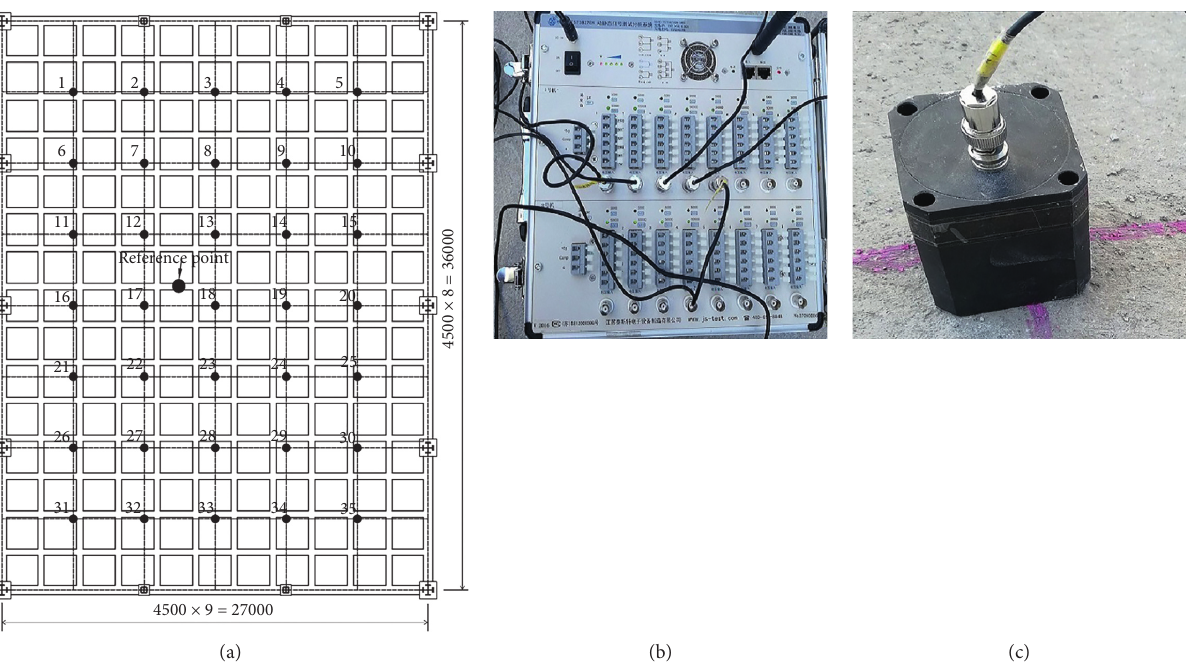
Figure 4: Testing devices and measurement locations: (a) measurement locations, (b) dynamic acquisition instrument, and (c) accelerometer.